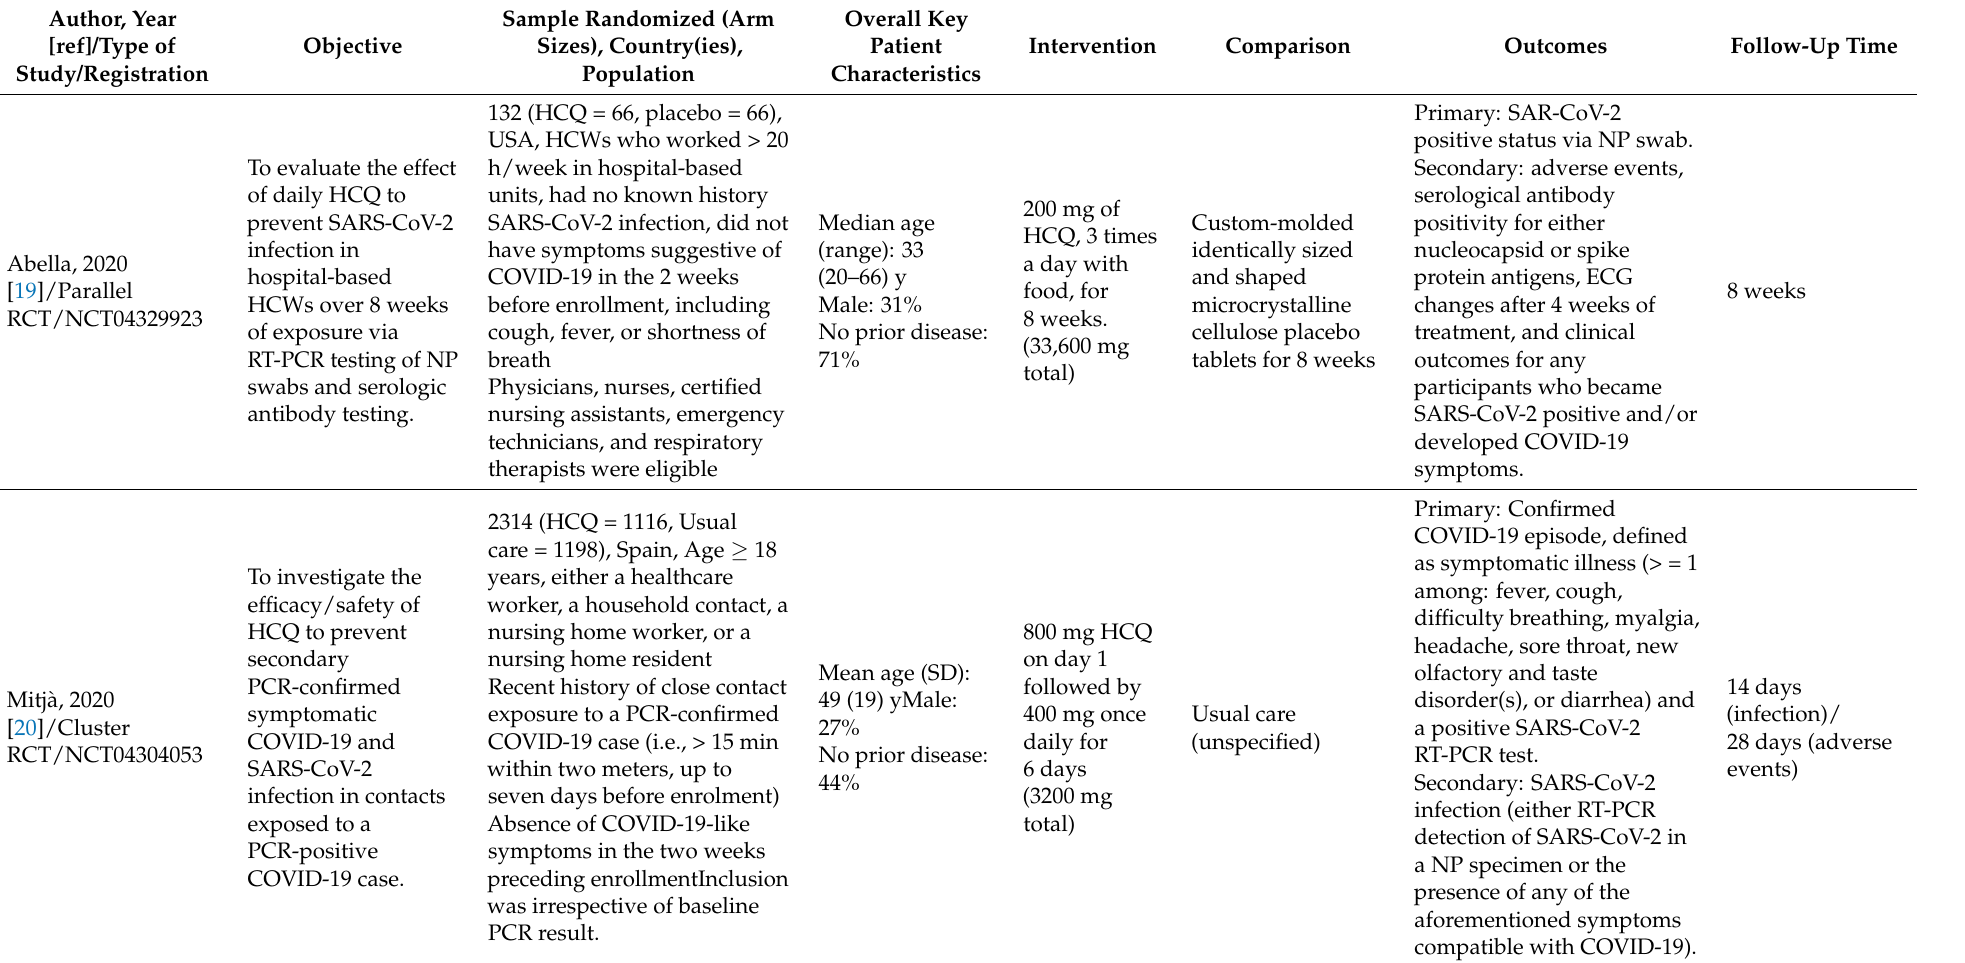
Table 1. Baseline characteristics of included randomized controlled